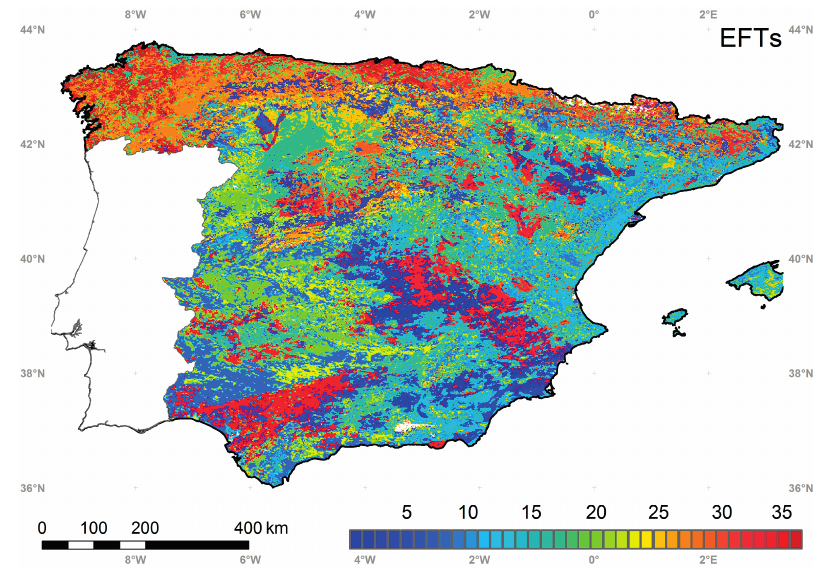
Figure B. Distribution of the 36 EFTs in Spain.